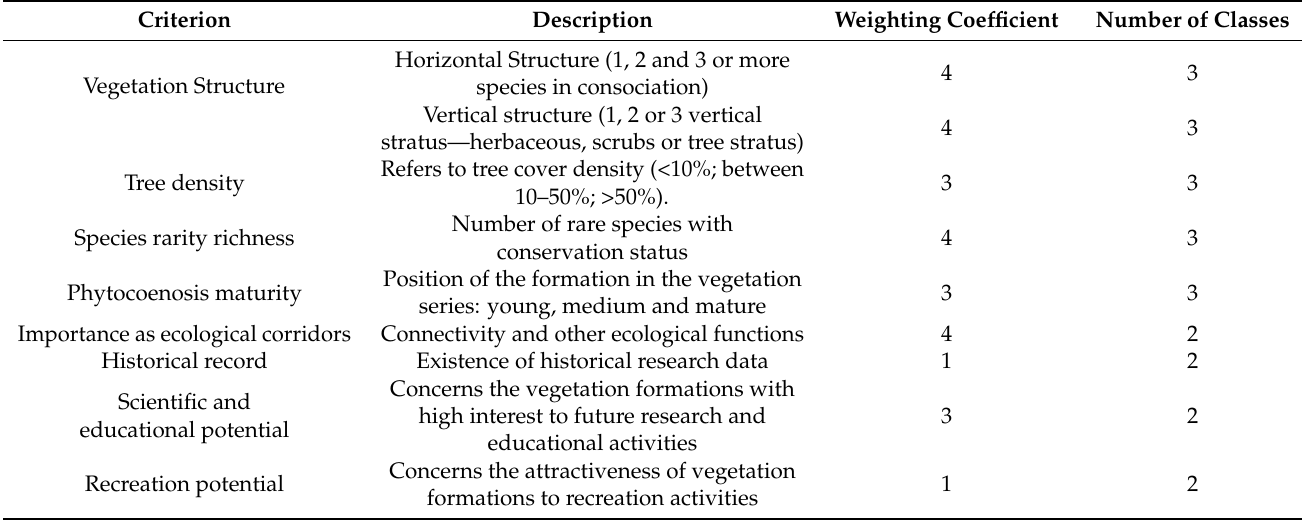
Table 2. Vegetation Heritage Value (VHV): Criteria, weighting coefficients and evaluation classes.